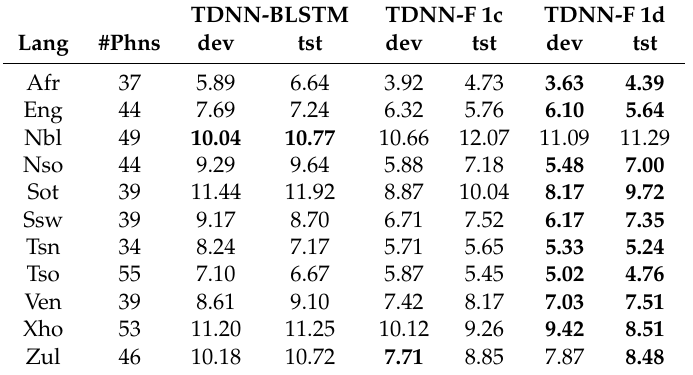
Table 7. PERs for TDNN-BLSTM and TDNN-F baseline systems per language (lowest PERs in